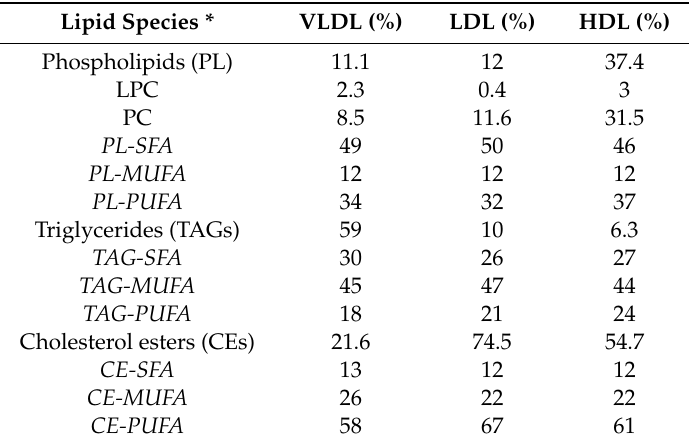
Table 2. Lipid composition of VLDLs, LDLs, and HDLs